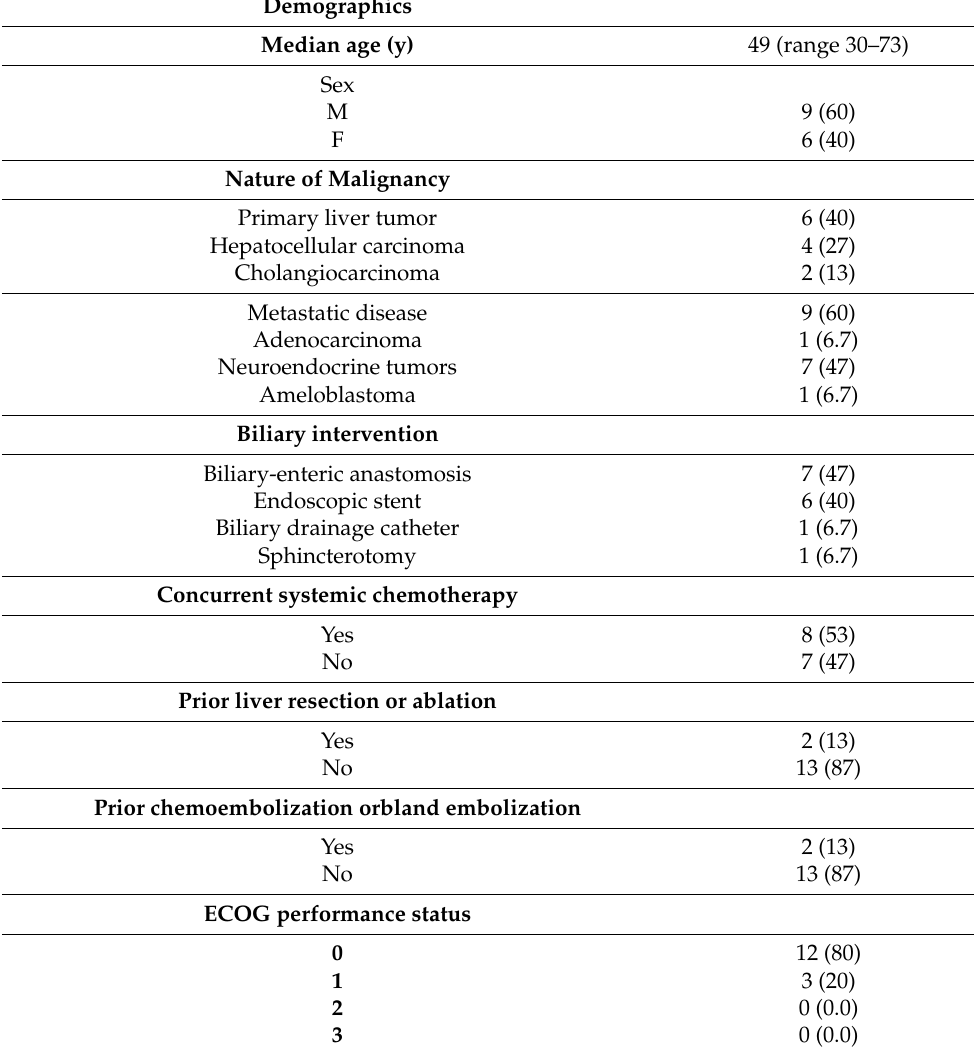
Table 1. Patients’